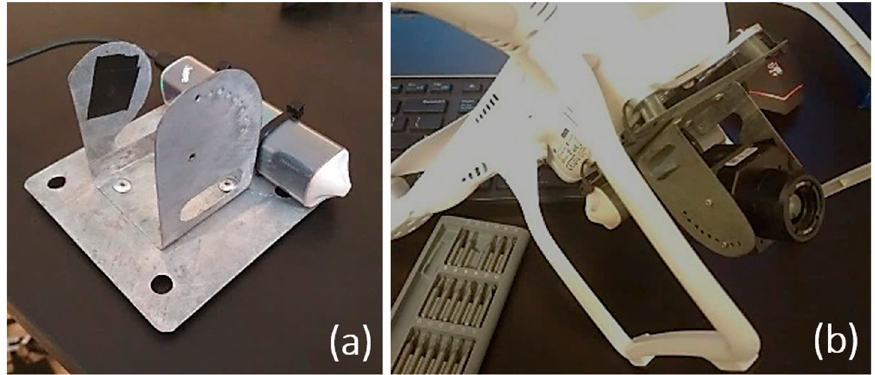
Figure 2. ( a ) Camera mounting unit ( b ) UAV with mounting unit and camera used in the